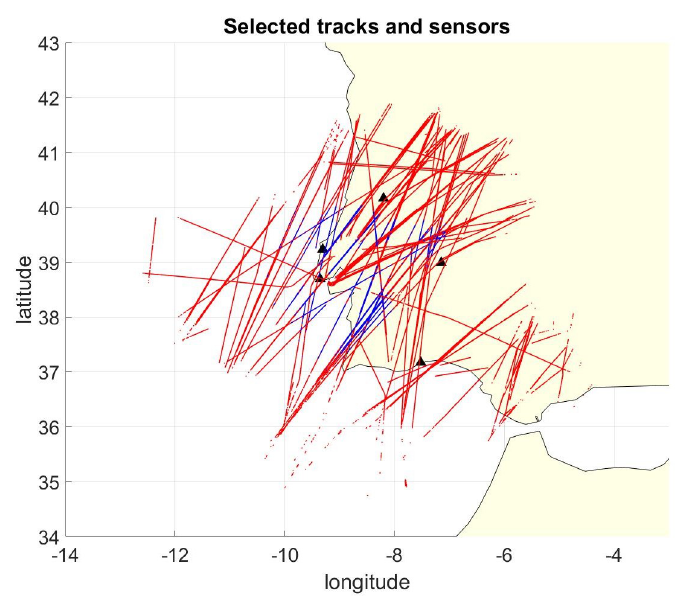
Figure 2. ADS-B tracked routes and selected stations. In the red position, it is not possible to apply the classic MLAT localization algorithm ( M < 4).